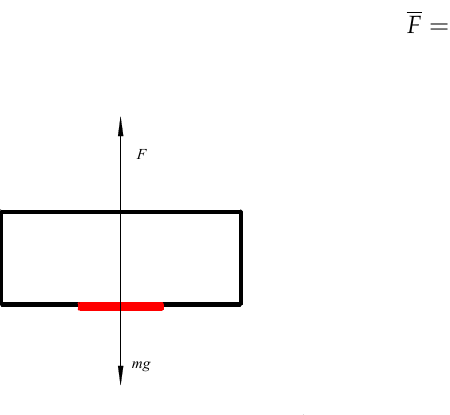
Figure 4. Instantaneous stress during impact.